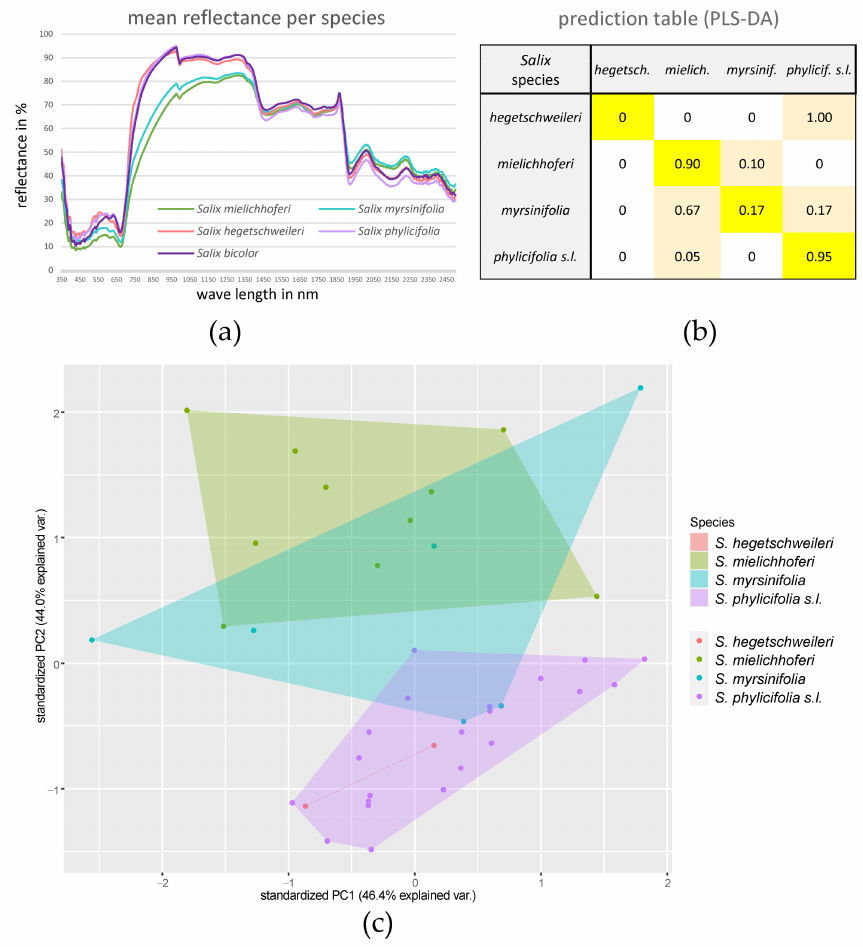
Figure 4. Infrared spectroscopy data. ( a ) Mean reflectance per species; species color-coded